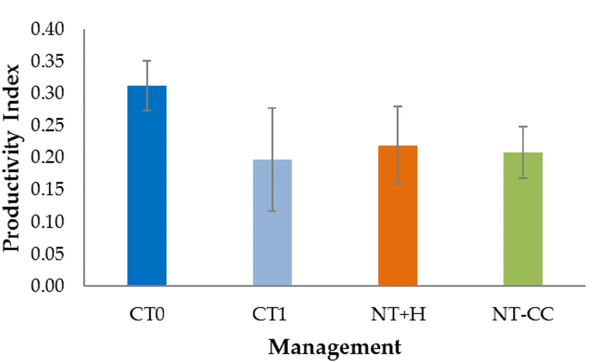
Figure 3. Productivity Index (PI), taking into account the entire soil profiles. CT0: conventional tillage 2004; CT1: conventional tillage 2019; NT + H: no tillage 2019; NT + CC: no tillage with cover. In relation to PI variation across the opened soil profiles, registered data revealed that the PI was significantly reduced as the soil depth increased (Figure 4). The greatest soil PI was found in the superficial horizon under different soil management systems, ranging between 0.13 (CT0) to 0.10 (NT + H). PI values below 30 cm remained at less than 0.1 in all the deepest horizons under the analysed management systems. In the BW horizon, the values remained at intermediate levels between the upper and lower horizons. In this horizon, the highest PI values were recorded under CT0 (0.10).